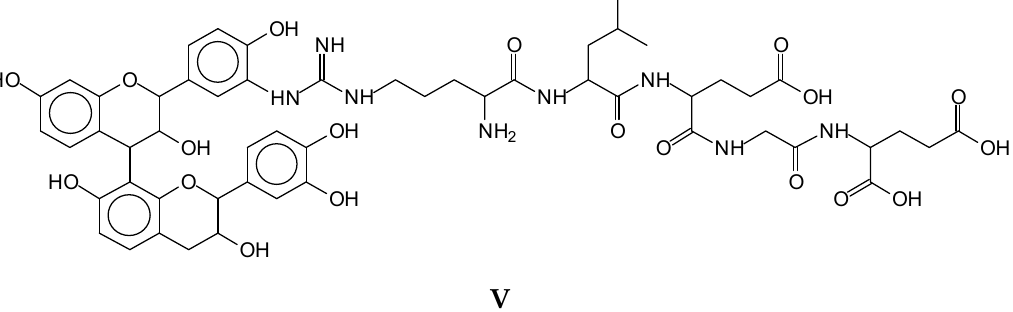
Figure 8. Example of a species ( V ) contributing to protein and tannin cross-linking in which a flavonoid oligomer is shown to react with the side chains of a peptide oligomer chain. Equally, this series of covalently linked oligomers can be interpreted as two flavonoid units being bridged by the same arginine–leucine–aspartic acid–glycine-glutamic acid peptide as, i.e., for the peak at 1128–1130 Da as in the alternative structure ( VI )(Figure